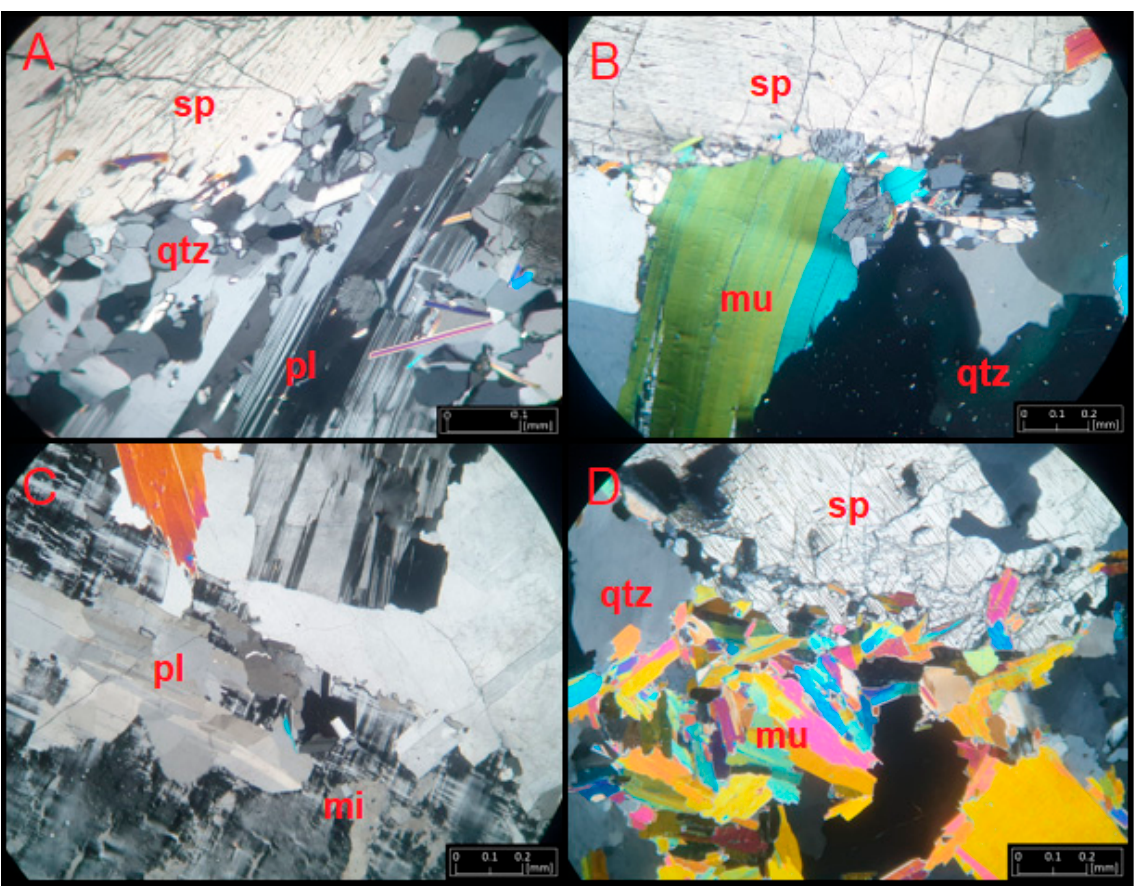
Figure 3. Microphotographs of the rocks from Kolmozero ( A , B ) and Kaustinen ( C , D ) with the typical association of the minerals and structures of rocks. There are present and microcline (mi), plagioclase (pl), quartz (qtz), muscovite (mu) and spodumene (sp).